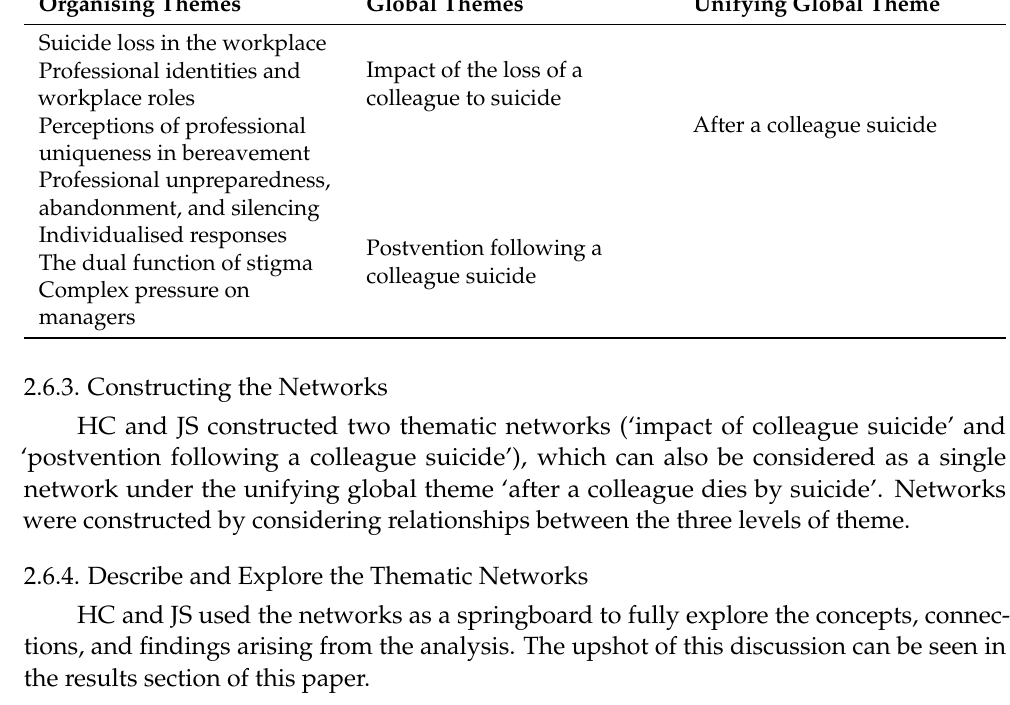
Table 5. Relationships and connections between the organising, global, and unifying global themes. Organising